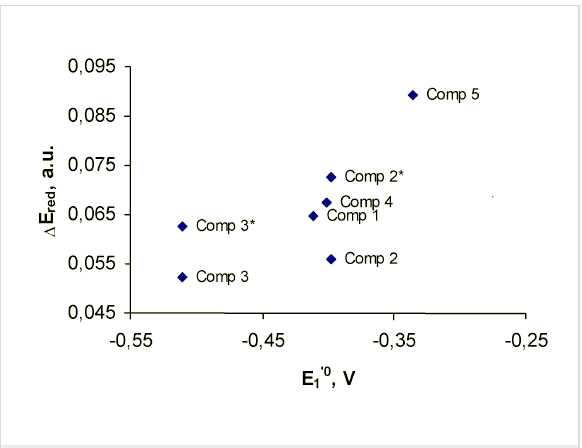
Figure 5: First formal redox-potentials of compounds 1 – 5 vs. their calculated energies of reduction.